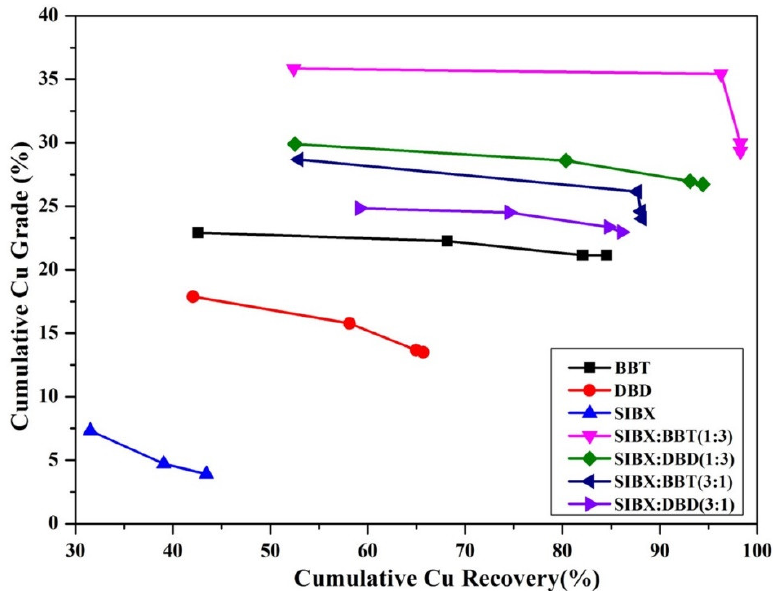
Figure 10. Copper recovery and grade for the three collectors (BBT, DBD and SIBX) and their mixtures in different proportion [59].